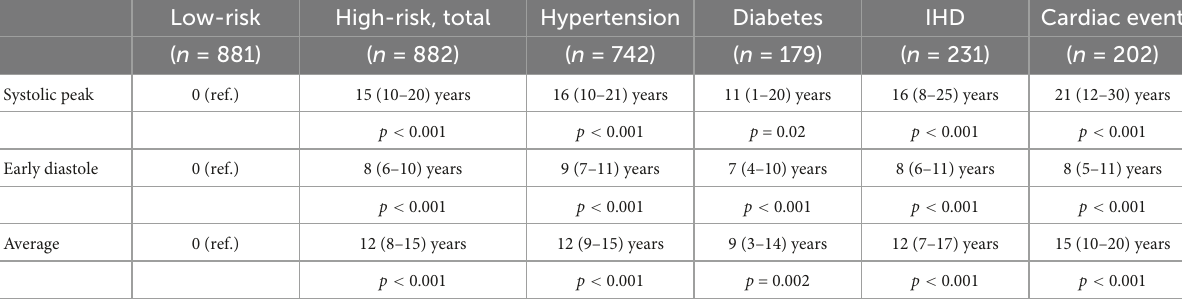
TABLE 3 Individual age gap between biological and chronological